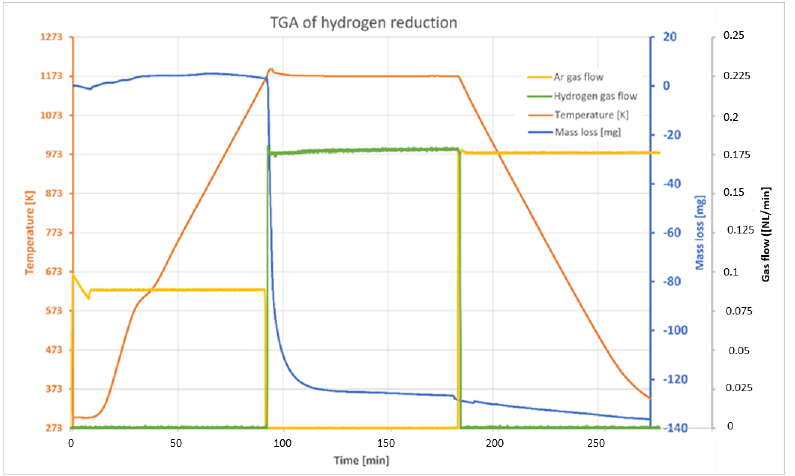
Figure 6. Thermogravimetric analysis of the reduction process with a 100% H 2 atmosphere of the calcined ore from the previous TGA.